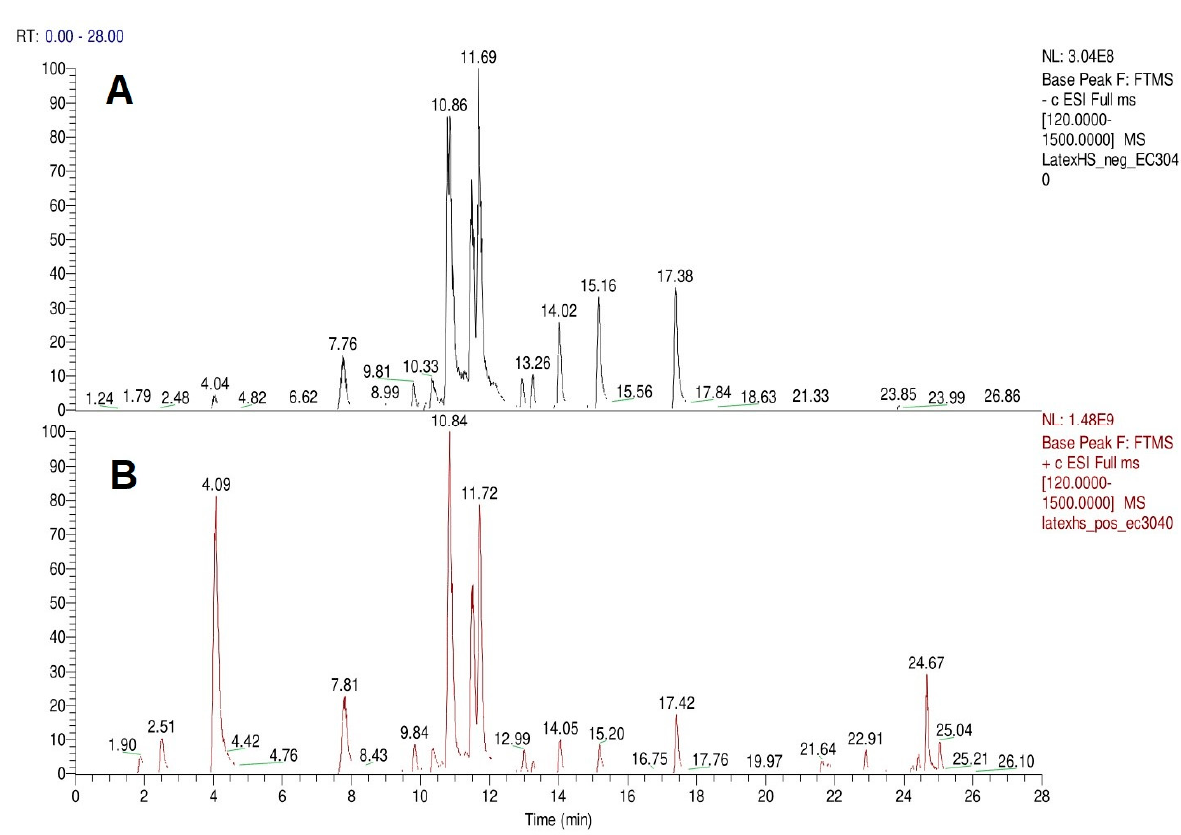
Figure 2. TIC chromatograms in negative ( A ) and positive ( B ) ESI mode of H. sucuuba